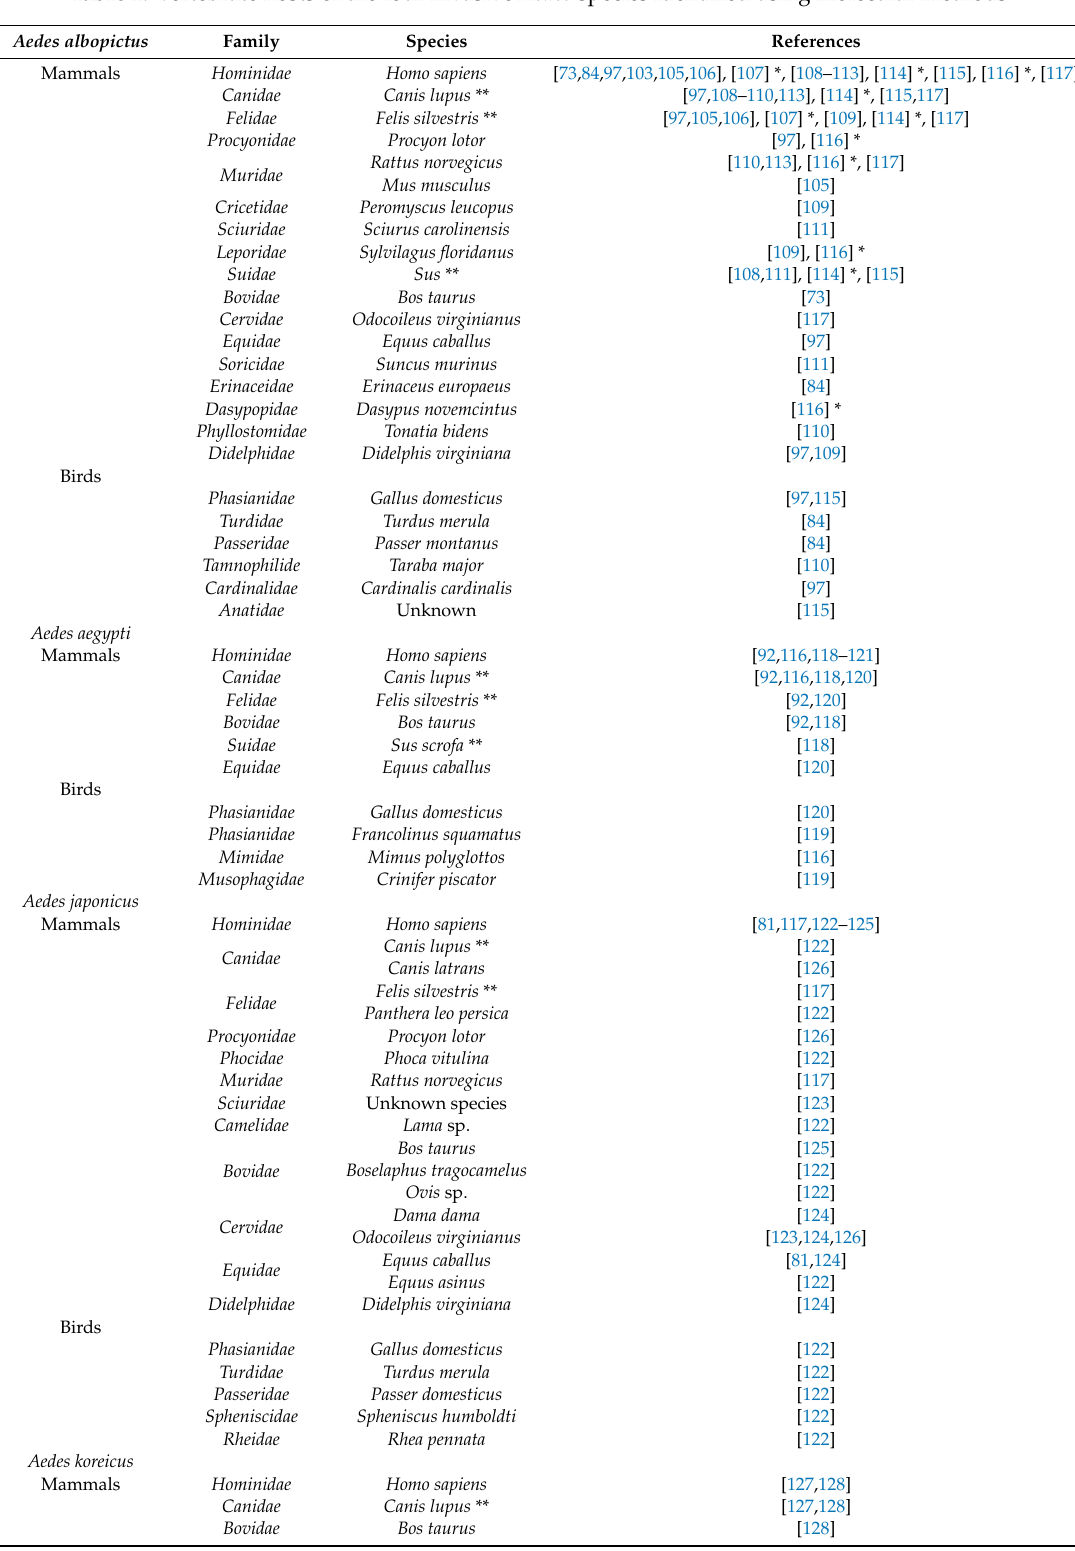
Table 1. Vertebrate hosts of the four invasive Aedes species identified using molecular